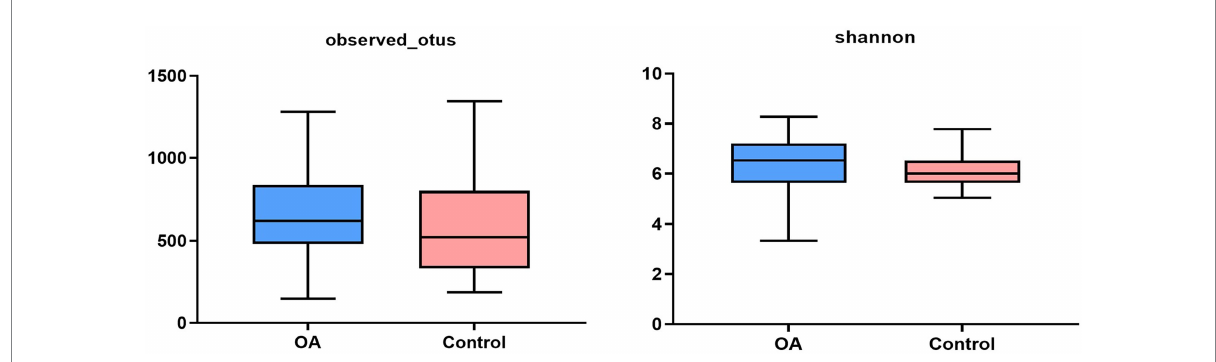
FIGURE 1 Alpha diversity indices between the two groups. OA, osteoarthritis.